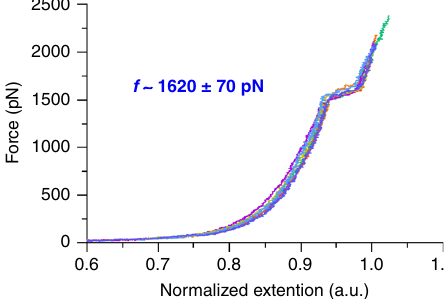
Fig. 7 Representative force – extension curves of P1. SMFS study was performed in toluene with a pulling velocity of 300 nm/s. Seven force – extension curves are normalized at the extension related to 2 nN force and overlaid in the fi